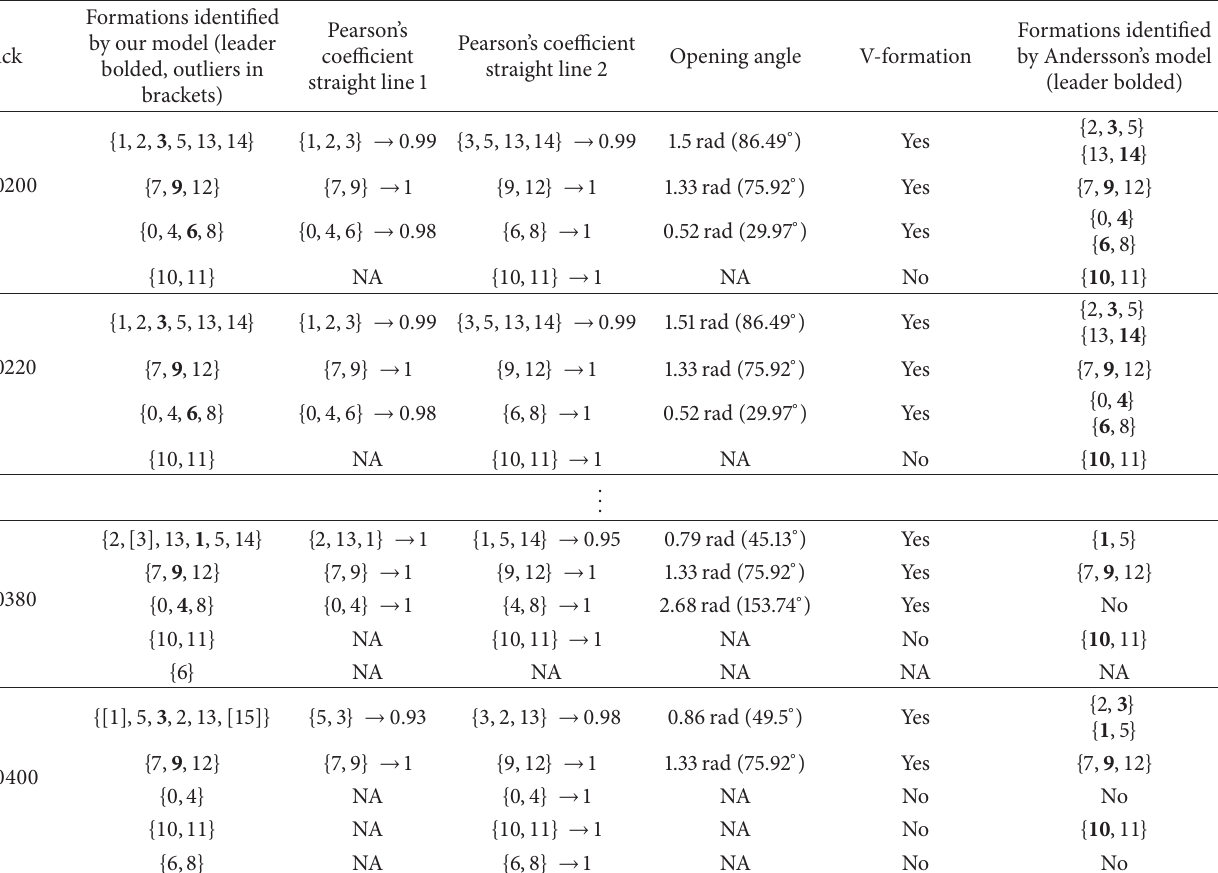
Table 3: V-formations: results of the experiment in NetLogo.